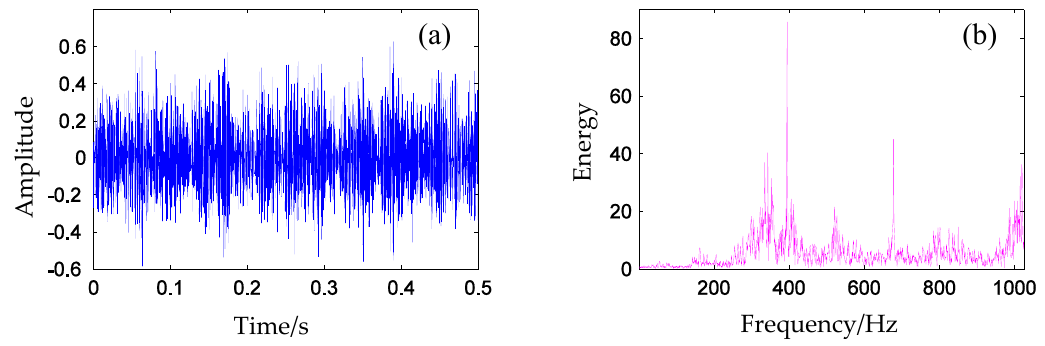
Figure 14. ( a ) Time-domain signal and ( b ) Fourier spectrum of the signal.